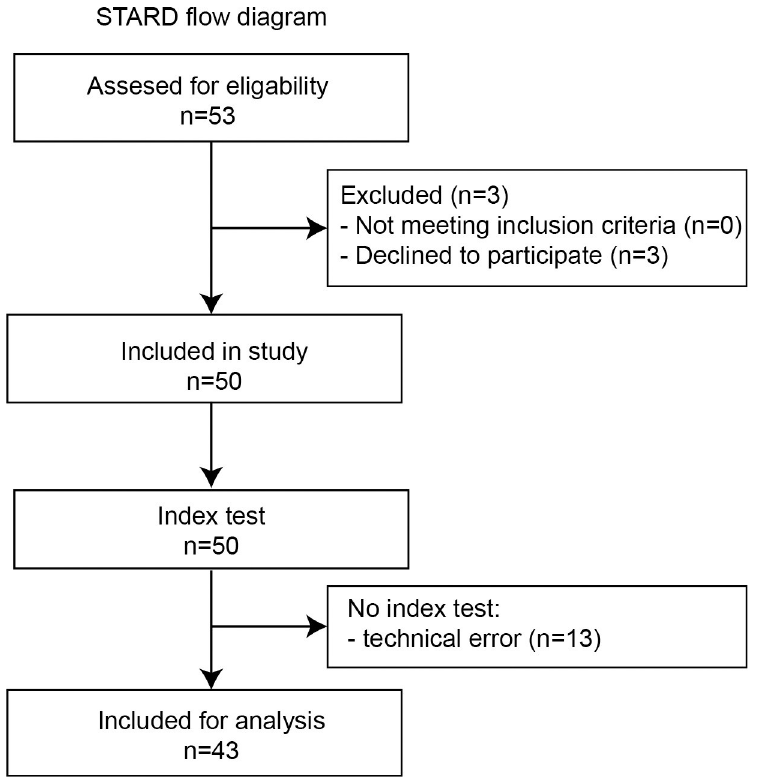
Fig 1. STARD flow diagram illustrating participant flow of the keratoconus population of the MORE-trial. All included participants underwent the web-based (index test) and manifest assessments (reference test) of visual acuity and refractive